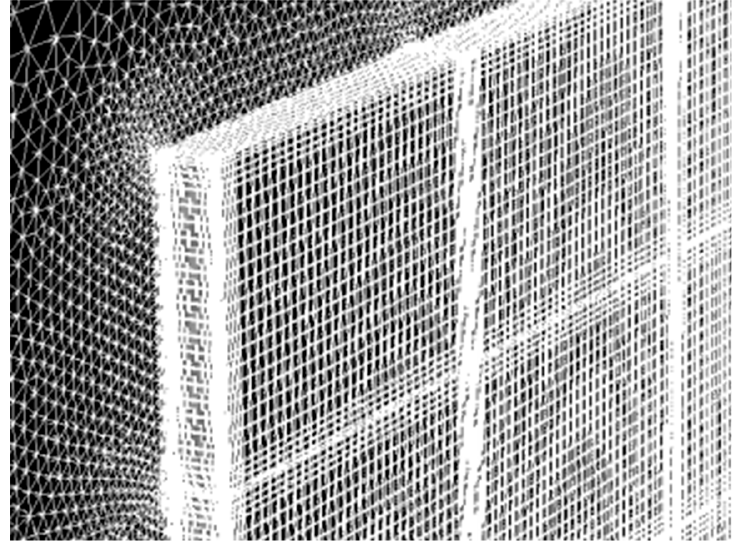
Figure 6. Mesh detail of the upper area of the OJVF.